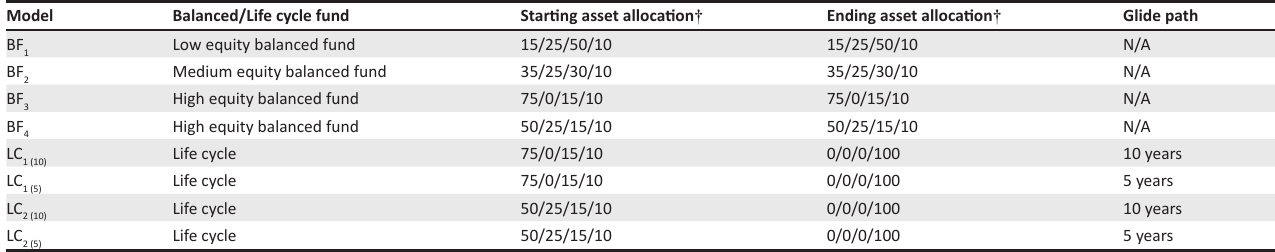
TABLE 1: Balanced and life cycle funds modelled.